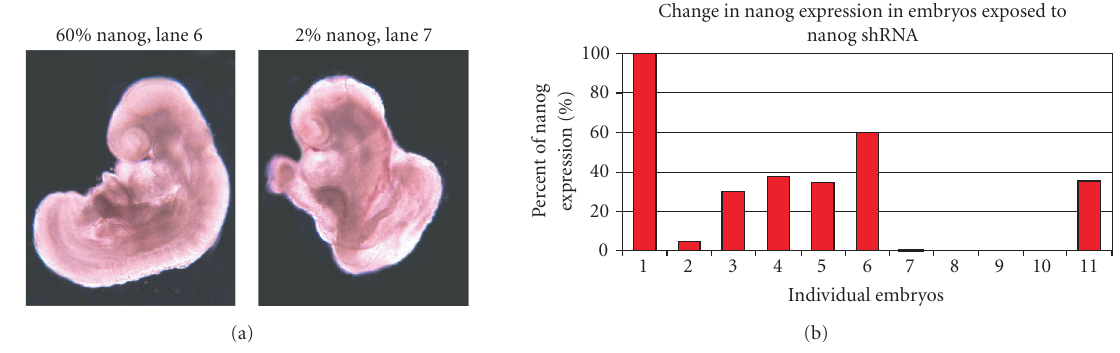
Figure 4: (a) Sideviews of two embryos exposed to nanog shRNA. Although the first embryo expressed 60% of wild-type levels of nanog mRNA, developmental defects are minor and include an axis abnormality and a flattened posterior neuropore. When nanog levels are reduced to 2% of wild type, embryos were more severely a ff ected. The embryo in the right panel is characterized by defects of somite segmentation, neural tube closure, and abnormalities of endoderm di ff erentiation. (b) Q-PCR analysis of nanog mRNA expression levels in individual embryos. Embryos were exposed on E6.5 to the nanog shRNA and examined on E9.0. cDNA from each embryo was run in triplicate in quantitative PCR with primers to both nanog and β -actin using the Clontech Qzyme system. Levels of β -actin and nanog expression from nanog shRNA-treated embryos (lanes 2–11) were compared to expression in a control embryo (lane 1). Nanog expression ranged from 0–60% of control levels. .